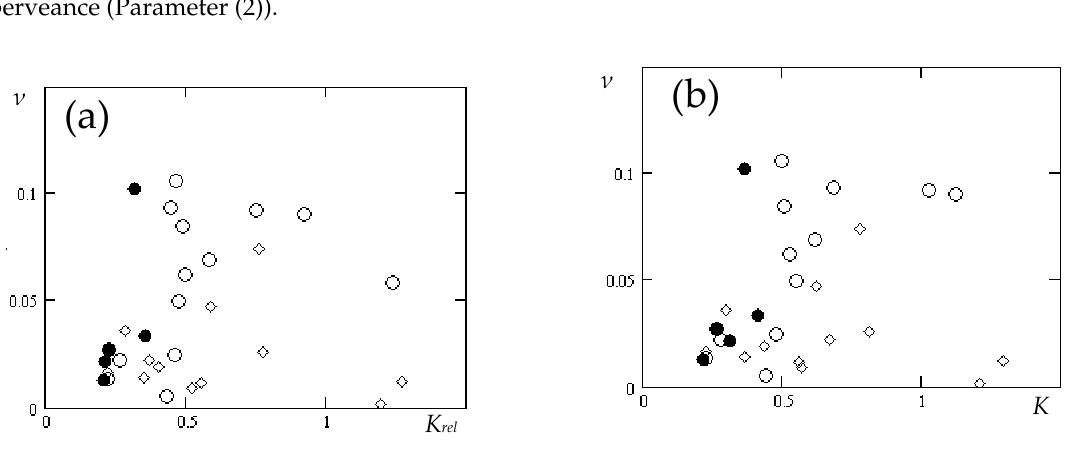
Figure 4. Produced klystrons: ( a ) in the coordinates ( K rel - ν ,), ( b ) in the coordinates ( K- ν ), divided into three groups by e ffi ciency level: ♦ η < 40%, η = 40–60%, η > 60%. (cid:35)